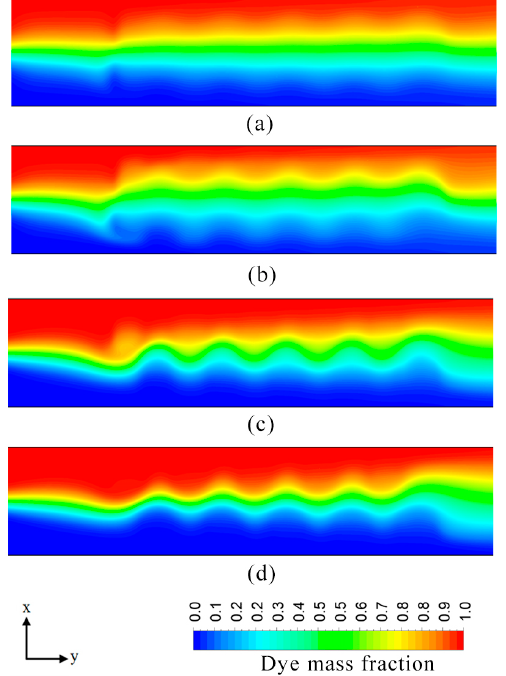
Figure 14. Dye mass fraction distributions on x - y plane along the channel length at z / H c = 0.5 for E = 400 V/cm: ( a ) P w / W c = 0.2; ( b ) P w / W c = 0.43; ( c ) P w / W c = 0.5; and ( d ) P w / W c = 0.6.